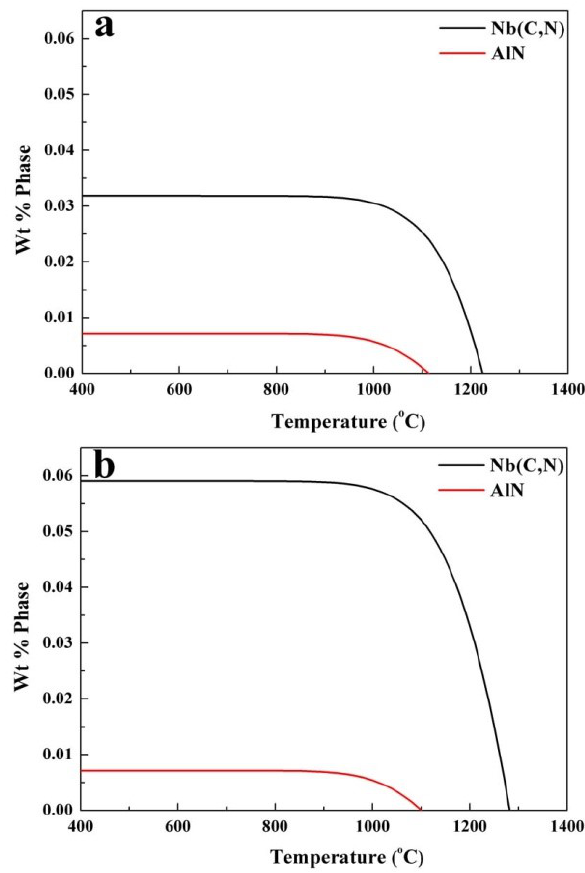
Figure 9: Phase diagram of silicon steels with different Nb contents (a) 0.028% Nb, (b) 0.052% Nb Table 2: Dissolution temperature of inhibitors / ∘